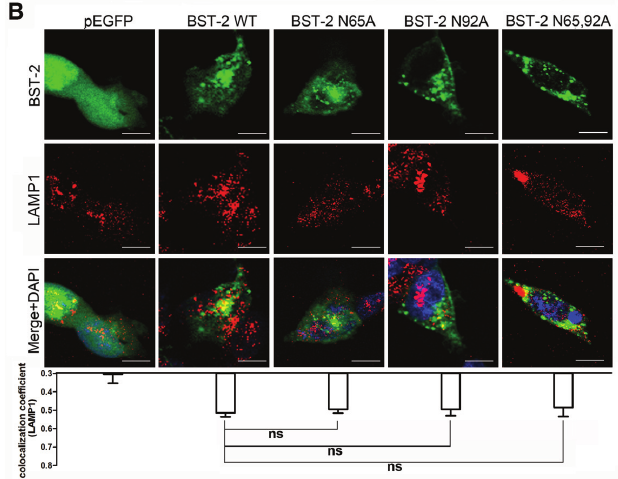
Figure 6. All BST-2 variants partially co-localize with EEA1 and LAMP1. ( A ) 293T cells transfected with 800 ng of BST-2 or its variants expression plasmids or pEGFP vectors were stained; blue, cell nucleus; green, BST-2 protein; red, EEA1 for early endosome; ( B ) 293T cells transfected with 800 ng of BST-2 or its variants expression plasmids or pEGFP vectors were stained; blue, cell nucleus; green, BST-2 protein; red, LAMP1 for lysosome. Images were taken under a Zeiss LZM710 confocal microscope. At least 30 individual cells were examined in each sample, and the most representative cells are shown. Co-localization coefficient (R) was calculated using Image-Pro Plus 6.0. Results were shown as mean ± SD. Statistical comparisons between the groups were performed by unpaired t -test using GraphPad Prism 5. * p < 0.05, ns (not significant) p > 0.05. Scale bars = 10 (cid:3)m.